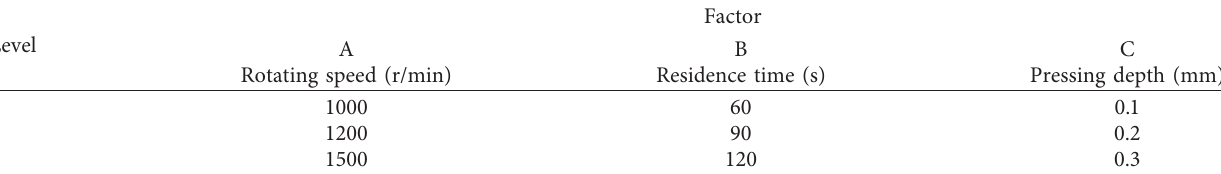
Table 2: Three factors and three levels selected in the orthogonal